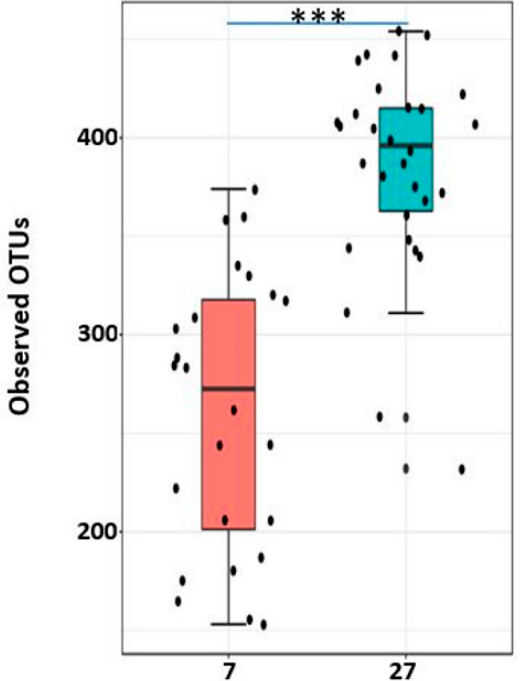
Figure 8. Alpha diversity between two post-weaning ages as measured by Observed_OTUS metric. *** represents significant difference between two groups at p < 0.0001. The 7 and 27 represent 7 and 27 days, respectively, after weaning. Increase in post-weaning age resulted an increase in alpha diversity.